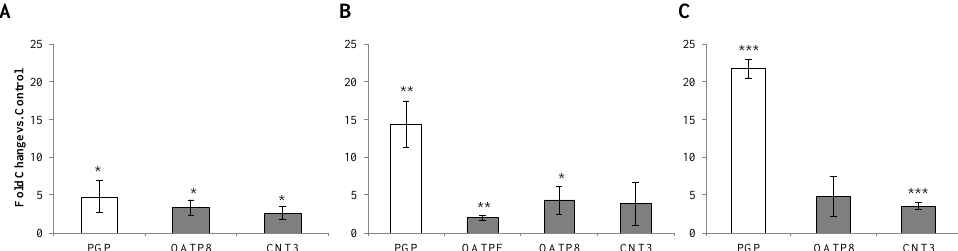
Figure 6. Drug transporter mRNA expression in VK2/E6E7 cells stimulated with pro-inflammatory cytokines. Quantitative PCR of cDNA was carried out using the SYBRgreen ® chemistry. ( A ) TNF- α ( B ) IL-1 β ( C ) IL-6 for 72 h. White bars represent ABC transporters. Grey bars represent SLC transporters. Data is presented as fold change versus medium control ±SD ( n = 3). Two-tailed stu- dents t -test * p < 0.05, ** p < 0.005, *** p < 0.001.